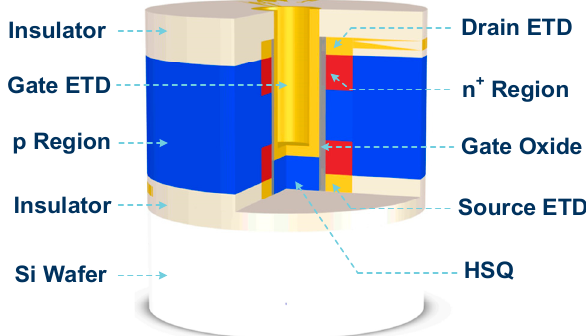
Figure 1. Schematic of the proposed vertical MOSFET. The proposed vertical MOSFET is potential in the implementation of M3D ICs. For example, the low on-resistance of vertical transistor can work as switch to control the elec- trical connection between tiers, and a 3-D inverter could be constructed in M3D ICs, as shown in Figure 2. The drains of PMOS and NMOS are connected by conductor trace line as the output, and their gates act as the input.